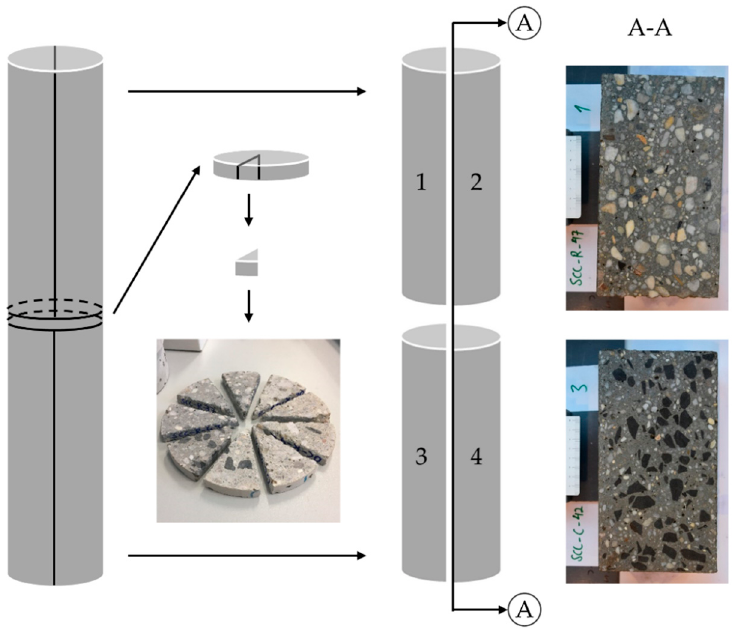
Figure 4. The cutting pattern for a “pumped” concrete specimen after hardening.